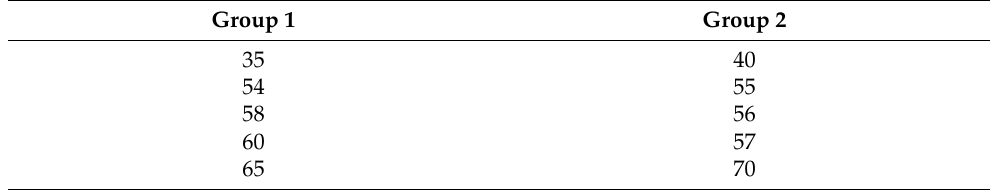
Table 1. EQ results for Groups 1 and